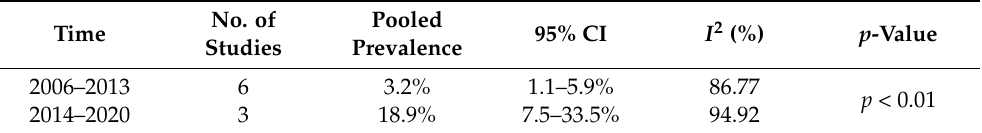
Table 8. Subgroup analysis of the prevalence of antimicrobial resistance of L. monocytogenes at different time periods.